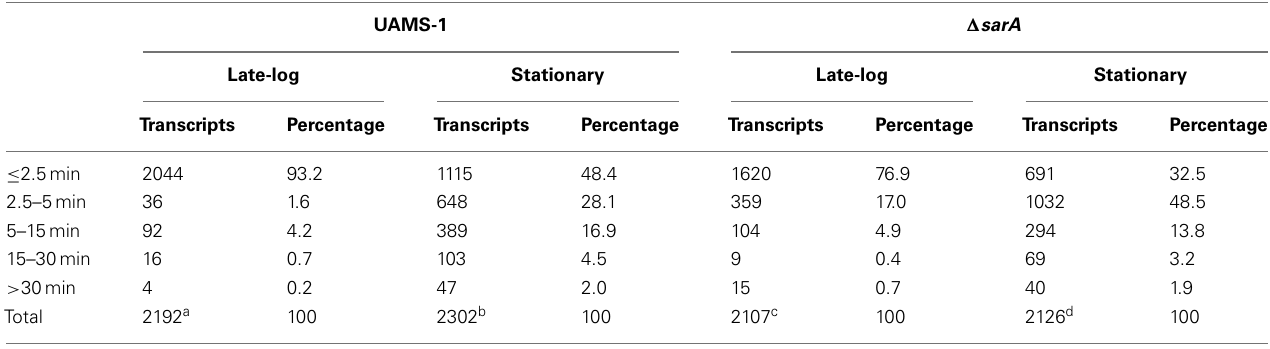
Table 3 | S. aureus growth phase mRNA